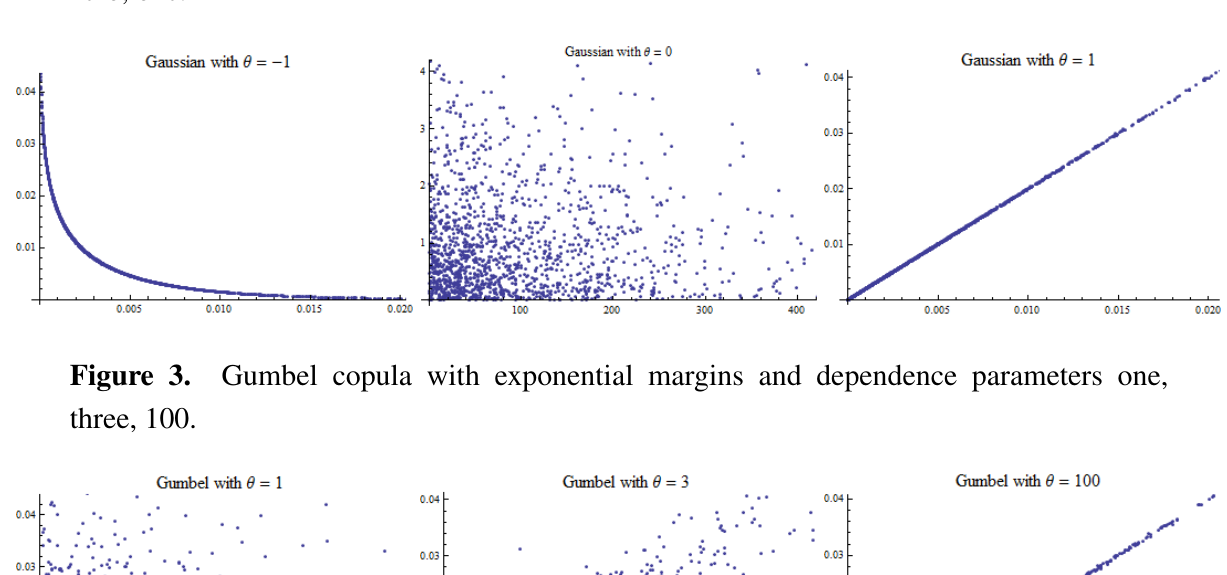
Figure 2. Gaussian copula with exponential margins and dependence parameters − 1, zero, one.